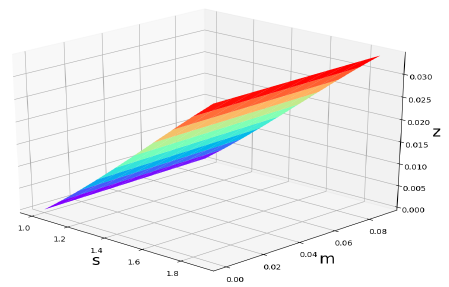
Figure 3. Parameter selection for s and m